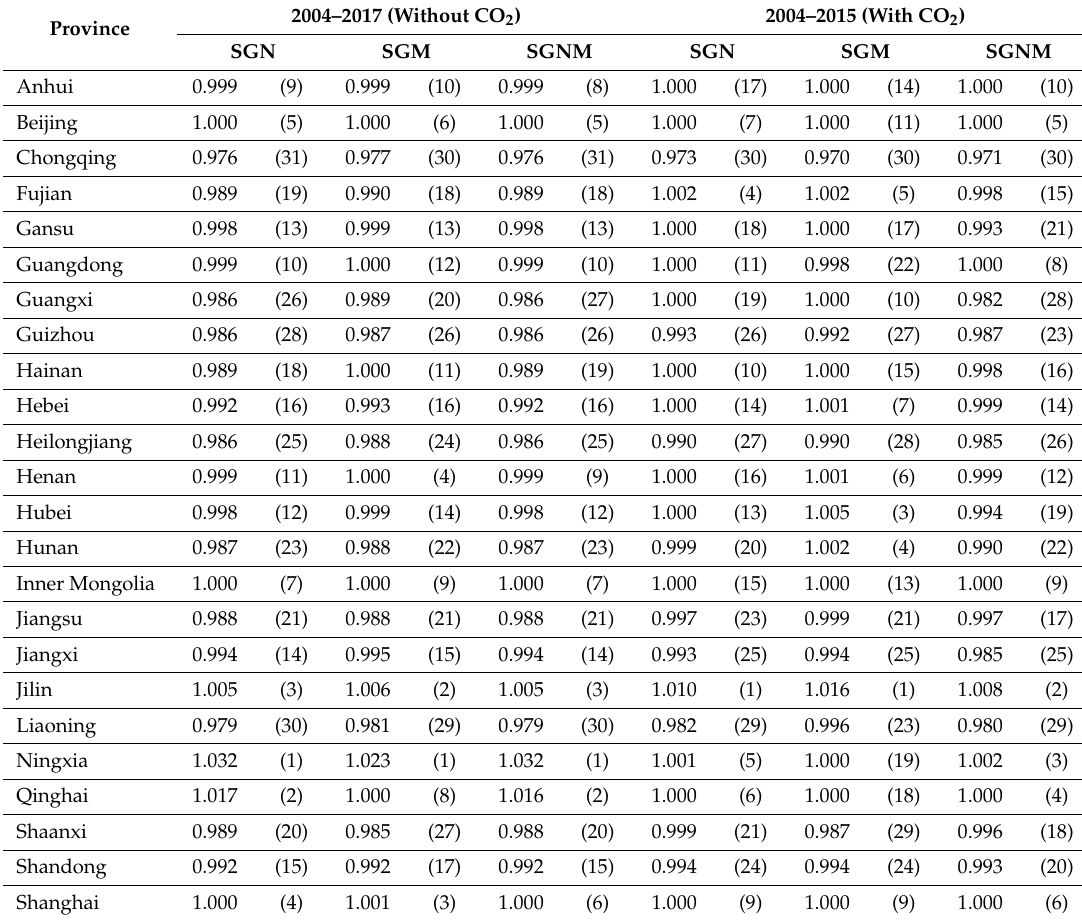
Table 3. Geometric means of SGN, SGM and SGNM for 2004–2017 and